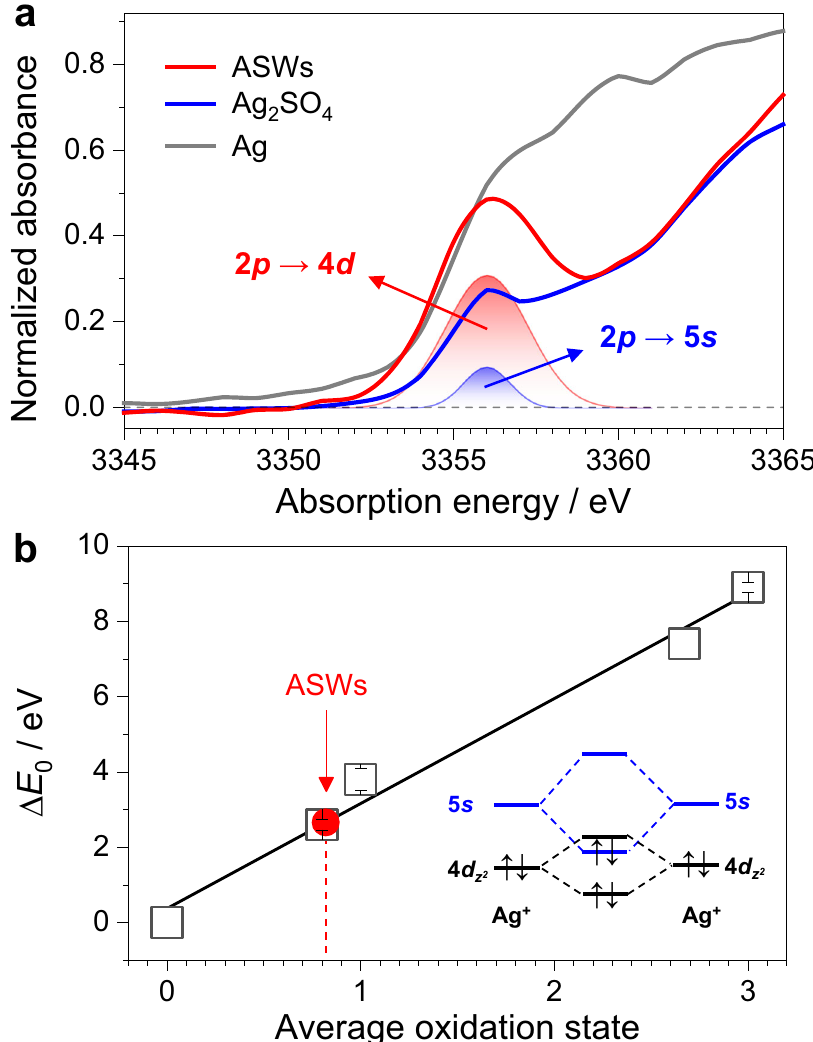
Fig. 4 Electronic structures of ASWs. a XANES spectra of ASWs and two references at the Ag L 3 -edge. Red and blue shades represent the edge peaks of ASWs and Ag 2 SO 4 , respectively. b The change of Ag L 1 -edge energy ( Δ E 0 ) versus average oxidation state. The Ag metal edge energy is selected as the reference energy, i.e., Δ E 0 = 0 eV. Data of binary silver oxides containing Ag in formal oxidation states of + 0.8, + 1, + 2.67, and + 3 were obtained from reference 31 . Inset: Schematic illustration of the 4 d – 5 s hybridization or overlapping among Ag atoms of ASWs leading to the 5 s bonding orbitals shifting down below the 4 d anti-bonding orbitals 15